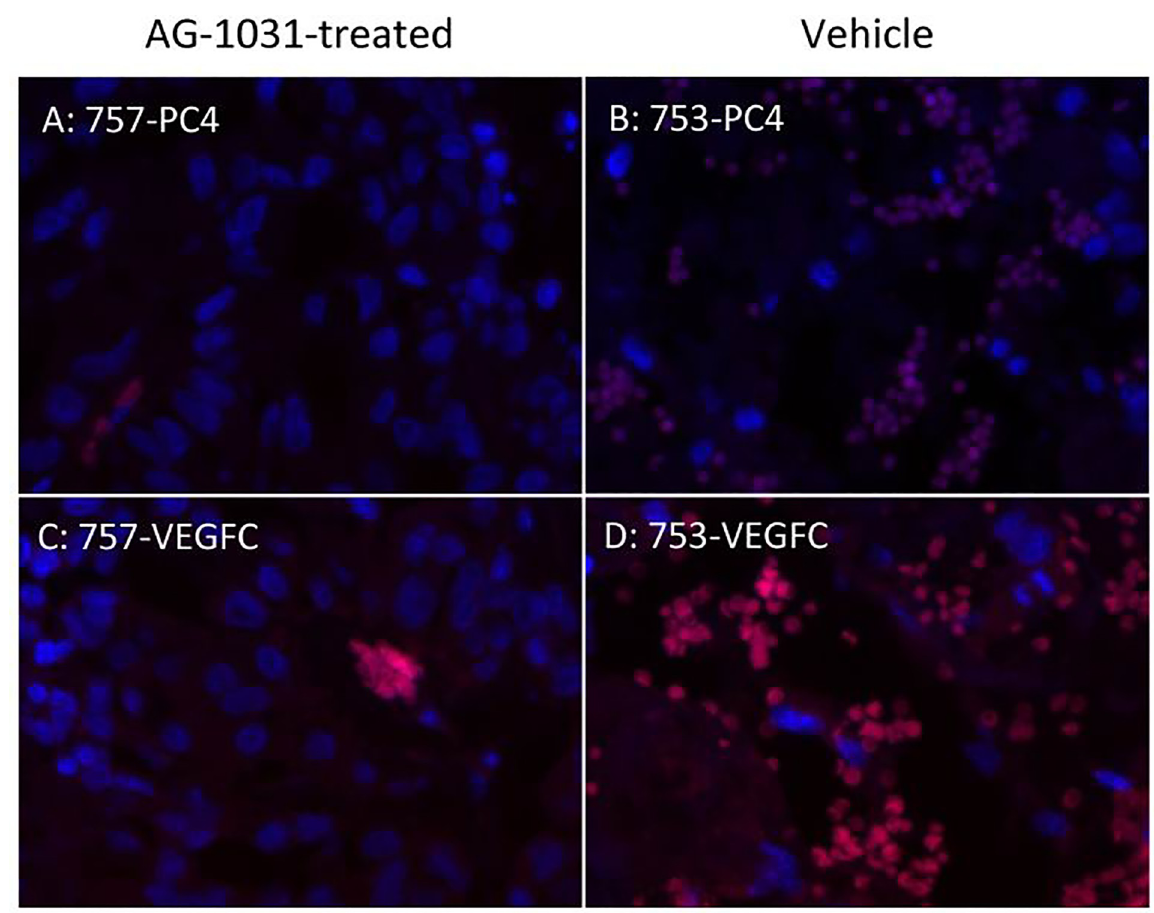
Fig 5. Down-regulation of PC4 correlates with down-regulation of VEGFC in AG-1031 treated tumor tissues. Tumor tissues from AG- 1031-treated A549 xenograft (#757) and from untreated xenograft (#753) were stained either with monoclonal antibody against PC4 (A and B) or with polyclonal antibody against VEGFC (C and D). Primary antibodies were detected using IgG-conjugated with rhodamine (A and B), Alexa Fluor 568 (C and D) and nuclei with DAPI (A, B, C and D).